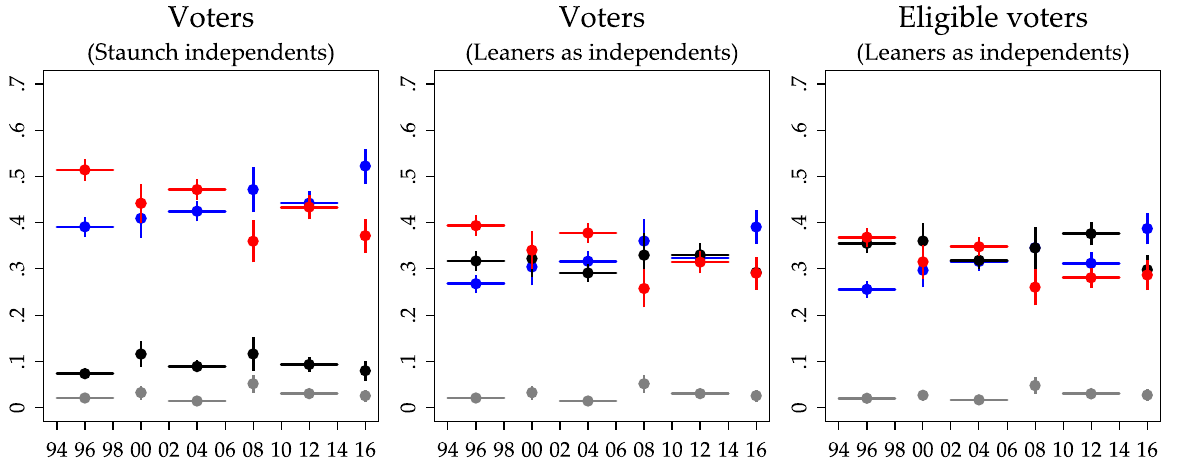
Figure 5: Class I trends in identification with the Democratic Party (blue), Republican Party (red), another party (gray), and independent (black).